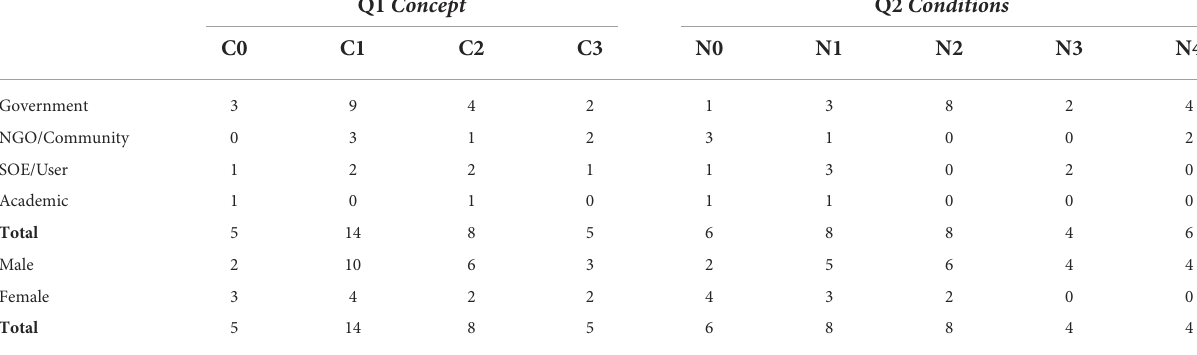
TABLE 9 Distribution of factor loadings by factor and respondent type.